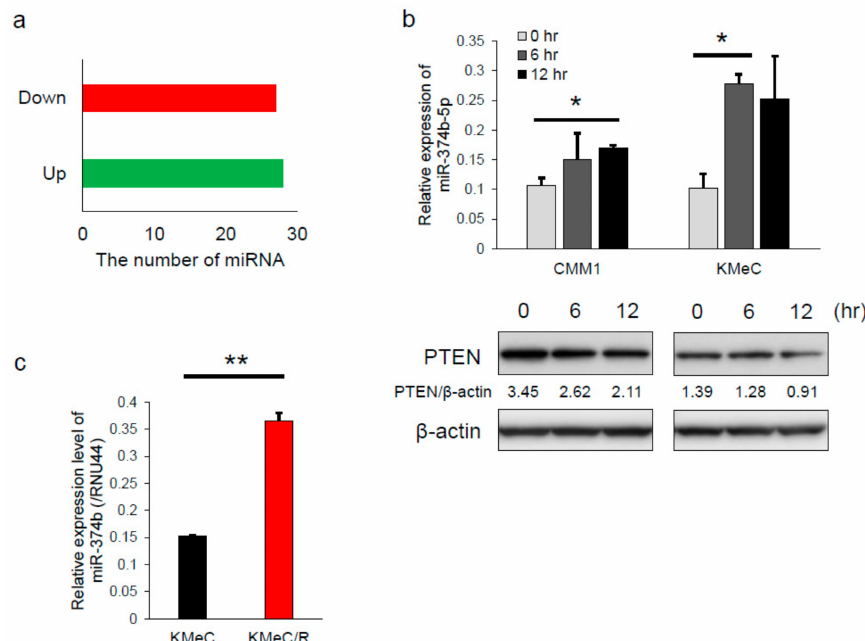
Figure 3. miR-374b upregulated in irradiated CoMM cells and radioresistant CoMM cells. ( a ) Results of microRNA microarray using human melanoma A2058 cells, showing numbers of upregulated and downregulated miRNAs. Total RNA was extracted before and 6 h after 2-Gy irradiation. ( b ) Expression level of miR-374b ( upper graph ) and PTEN ( lower panel ) in the CoMM cells before and 6 or 12 h after the 2-Gy irradiation. The values between the panel of PTEN and β -actin were the intensities of PTEN normalized to that of β -actin. ( c ) Expression level of miR-374b in KMeC cells and their radioresistant ones. * p < 0.05 and ** p < 0.01, for di ff erences between the samples indicated by the horizontal lines. Data are expressed as the mean + SD ( n =